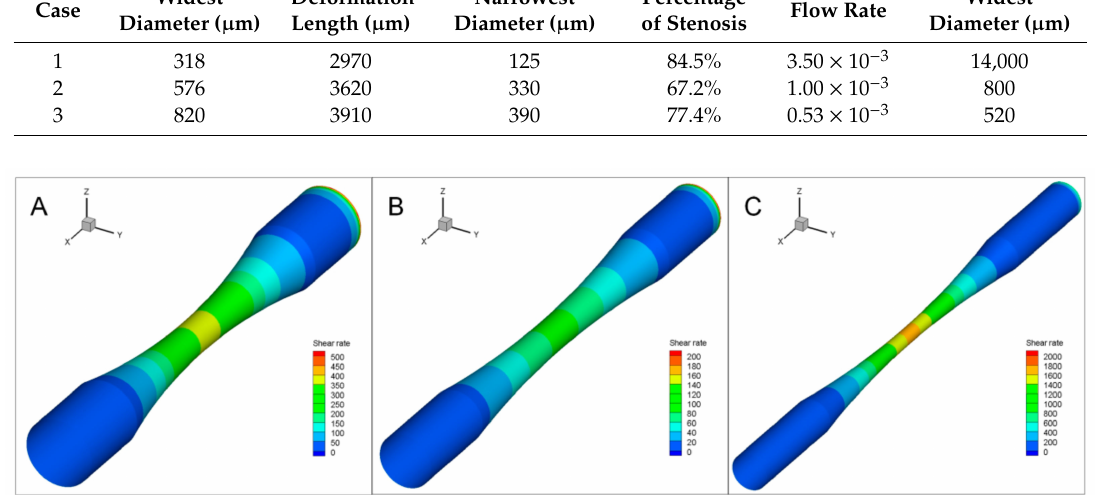
Figure 8. Computational simulation of wall shear rates (WSRs) in microchannels with a stenotic shape: Computational fluid dynamics analysis displayed WSR within the channel bottom in a